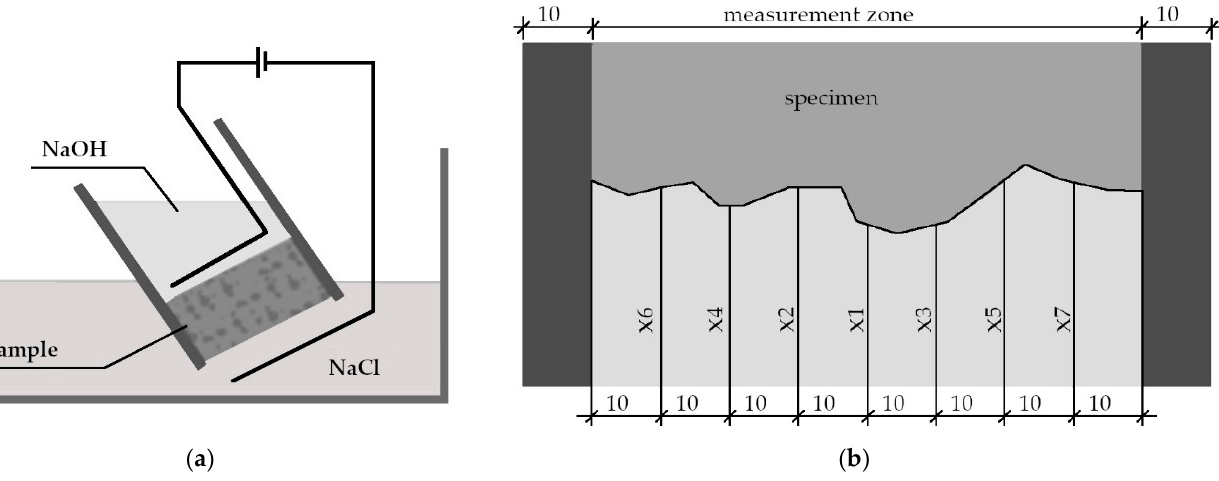
Figure 2. ( a ) NT BUILD 492 migration test scheme; ( b ) principle of chloride penetration depth meas- urement.